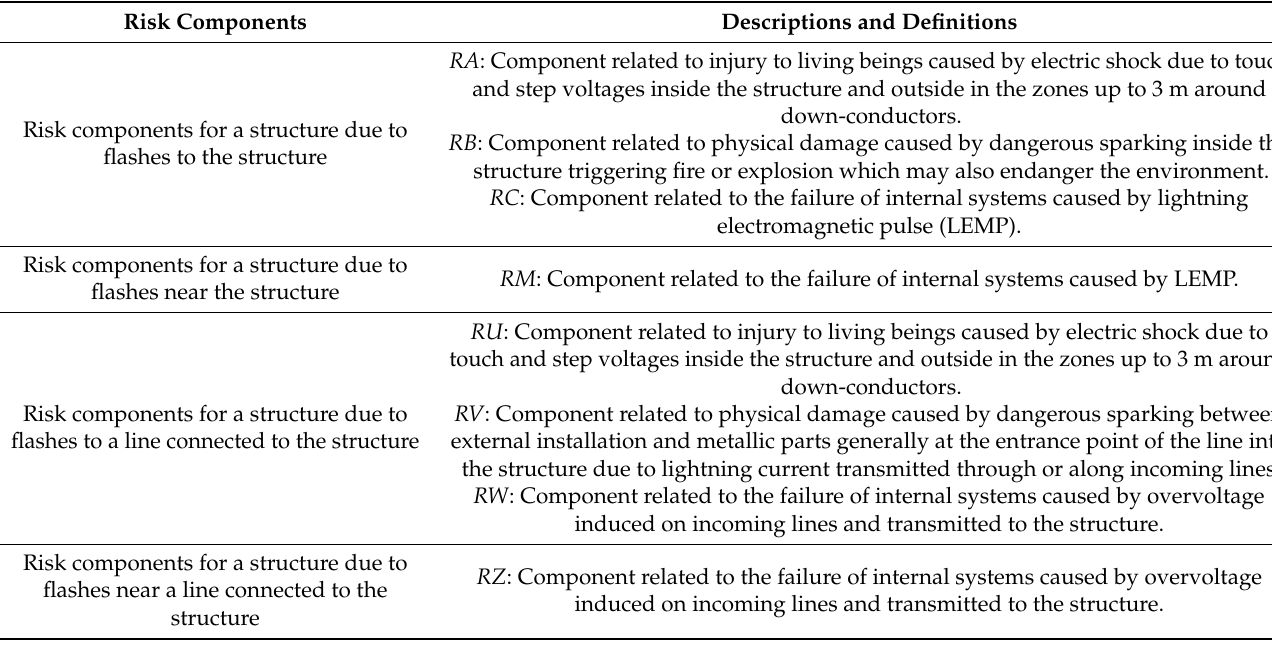
Table 5. Definitions of Risk Components (IEC